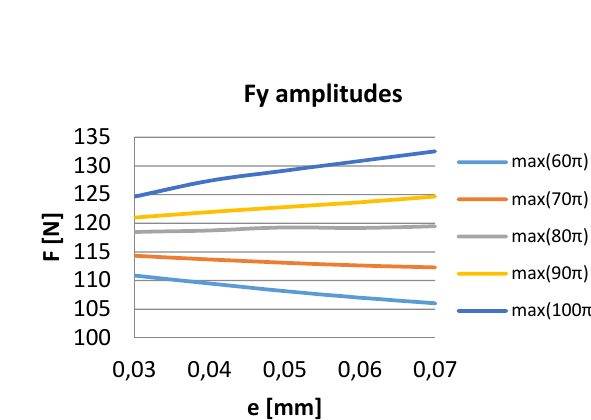
Fig. 11. Fy positive